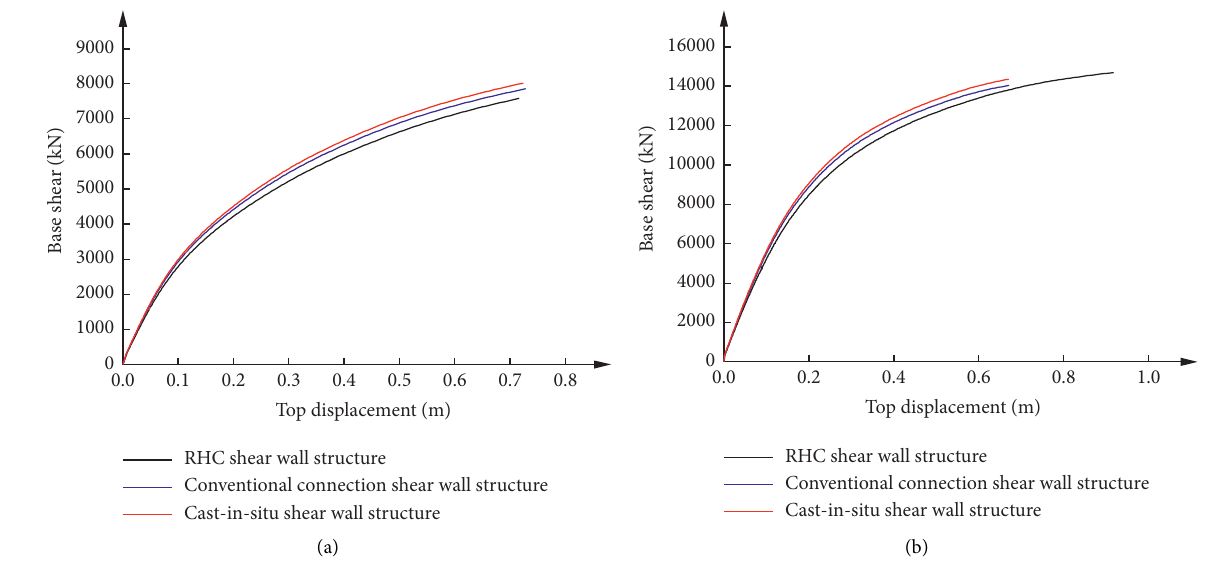
Figure 11: Pushover curves of three structures (a) In x direction (b) In y